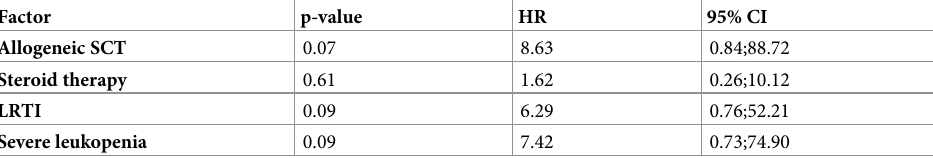
Table 4. Multivariate risk factor analysis regarding prolonged viral shedding > 14